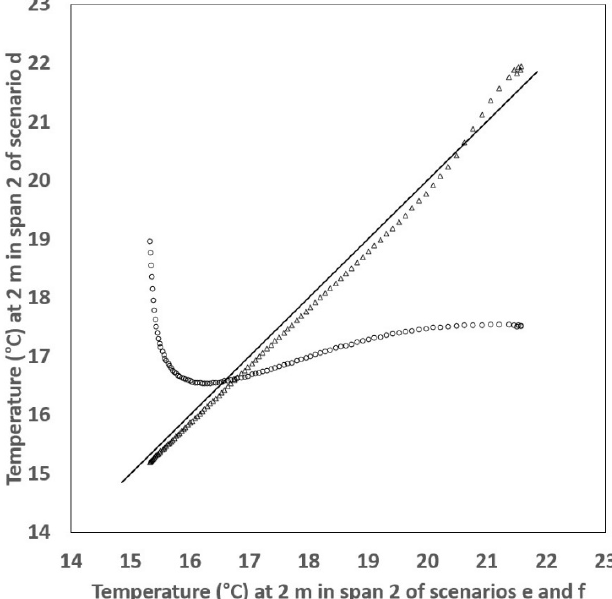
Figure 6. Temperature relationship (°C) at a 2 m height in span 2 of the greenhouse with 30 °C constant heating for 4 scenarios: d and e ( ∆) , and d and f (o).